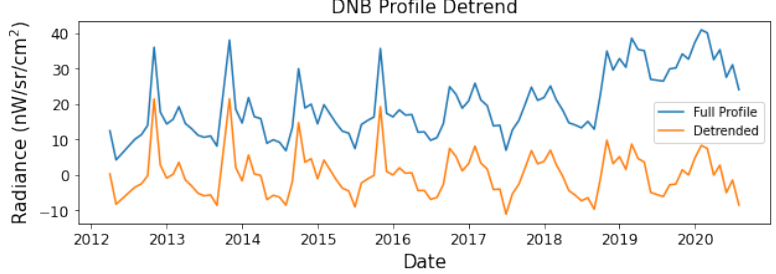
Figure 8. Detrending of the VNL monthly profile using the trend from STL.